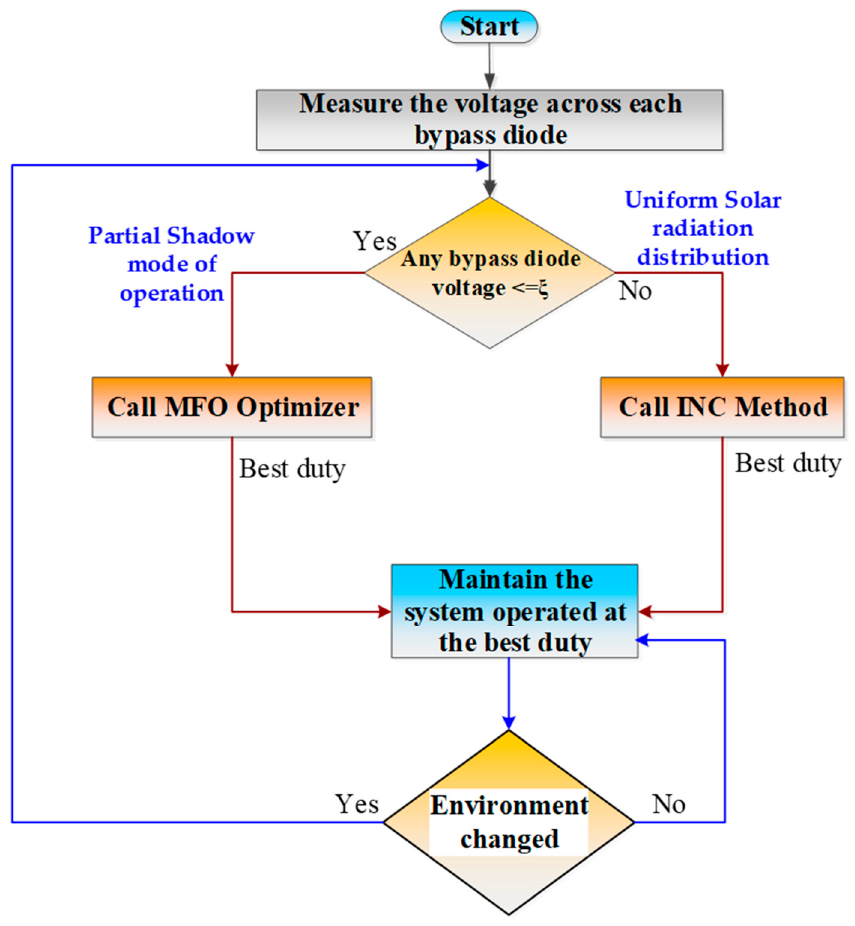
Figure 4. Flowchart of the proposed strategy. (Note: ξ denotes very small value).